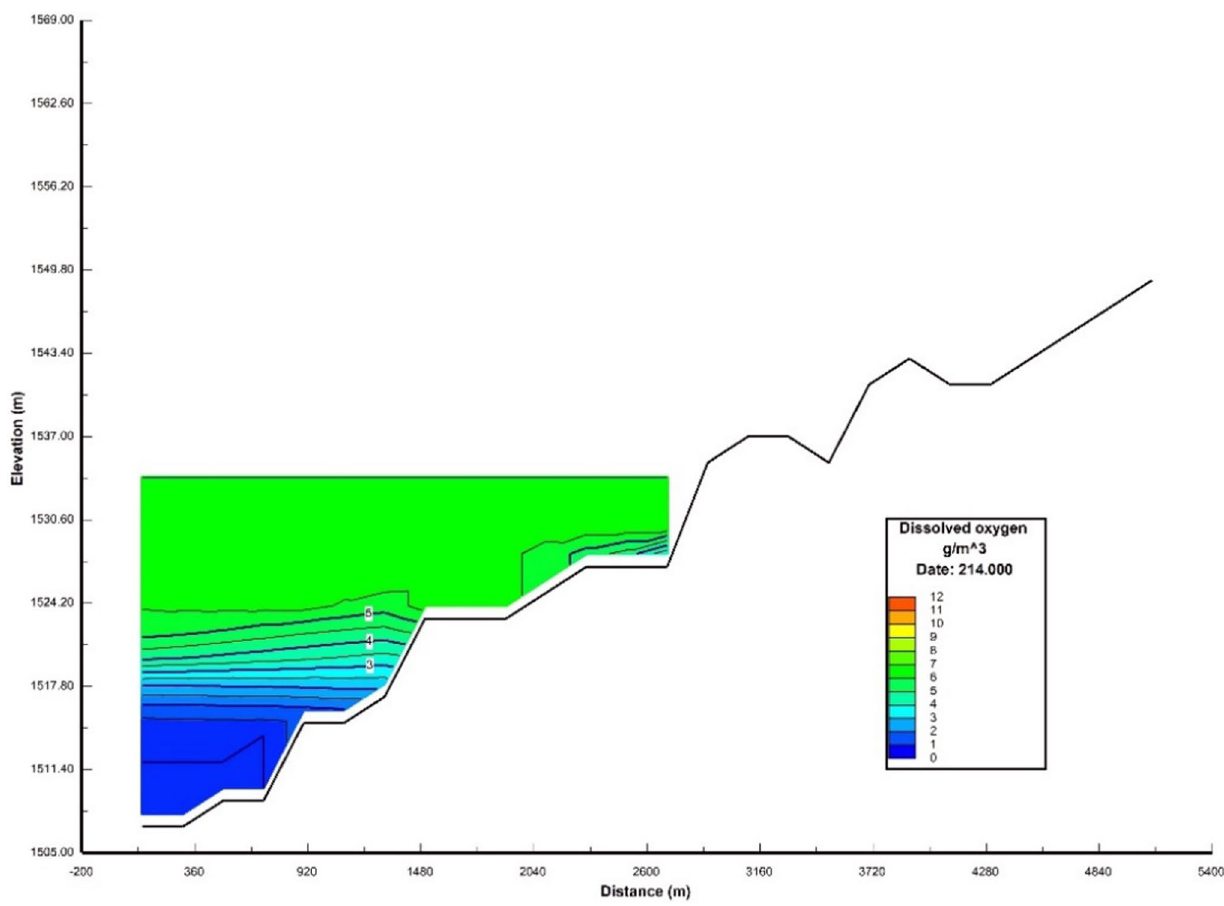
Fig. 9 The pattern of dissolved oxygen concentration in mid-August (Date: